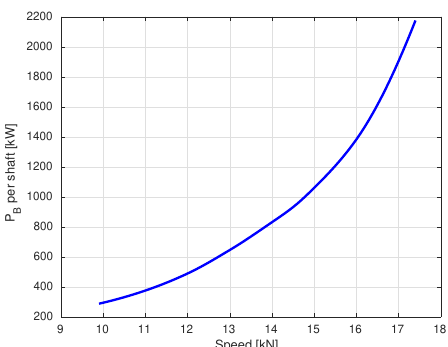
Figure 2. Vessel’s estimated brake power per shaft.